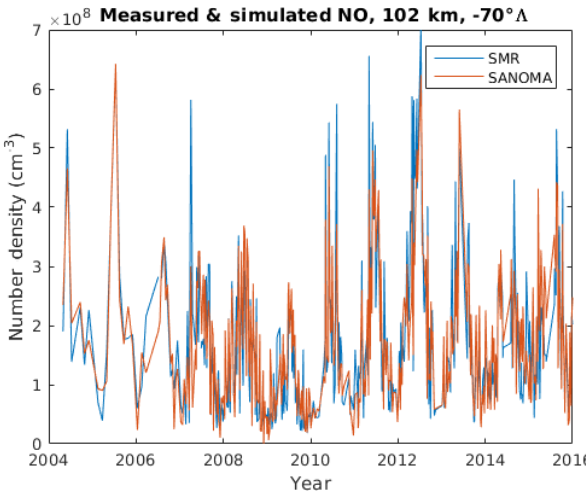
Figure 7. SMR-measured and SANOMA-simulated time series of NO at 102km and − 70 ◦ (cid:51)